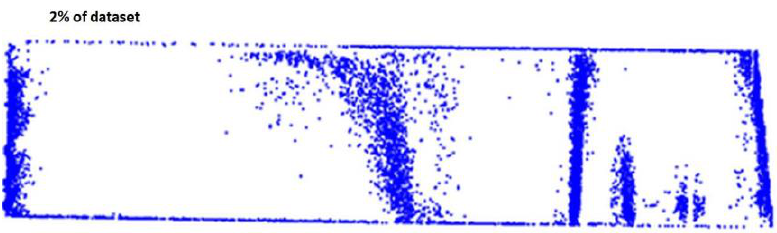
Figure 8. Optimized test area (13,976 points).